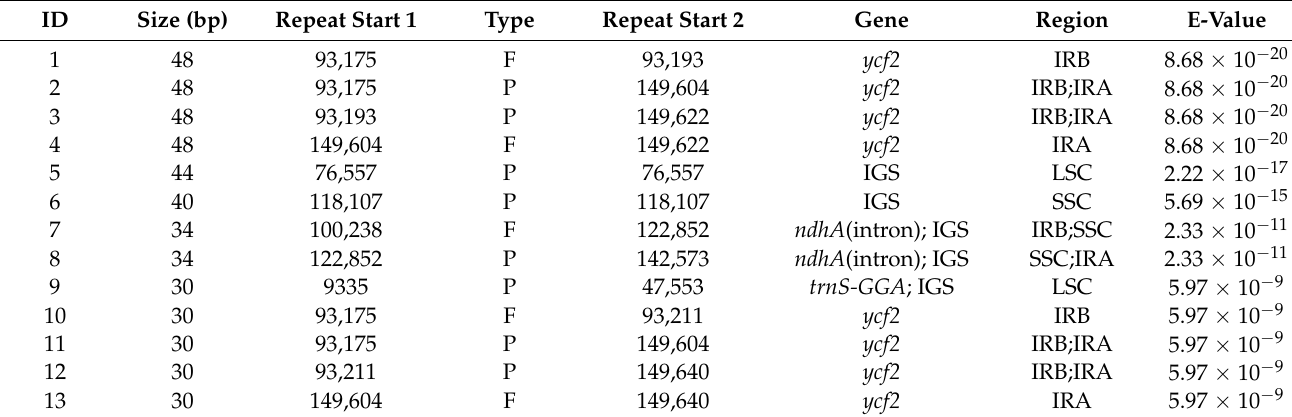
Table 2. Long repeats of D . oligodontus cpDNA.